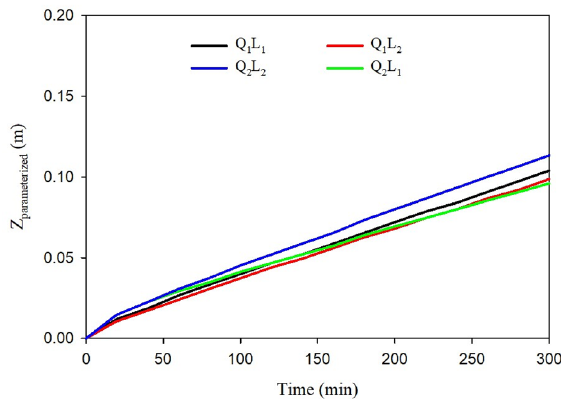
Figure 2. Estimated infiltrated water depth (Z parameterized ) for the continuous irrigation corresponding to the parameterized Kostiakov-Lewis equation as Table